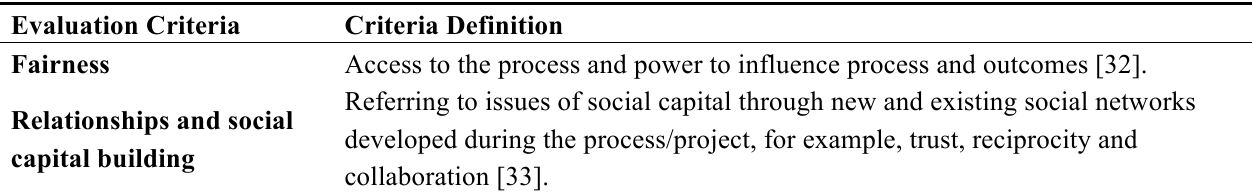
Table 1. List of criteria related to successful participatory planning selected by Menzel et al. [1] and based on a review of the literature. Seven main criteria of relevance to DSS identified by Menzel et al. [1] are in